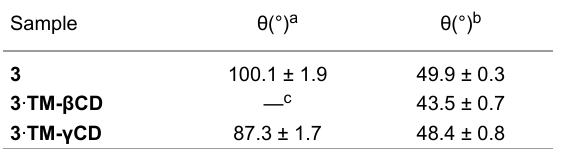
Table 3: Advancing contact angle of water and diiodometane measured on spin-coated film of compounds.